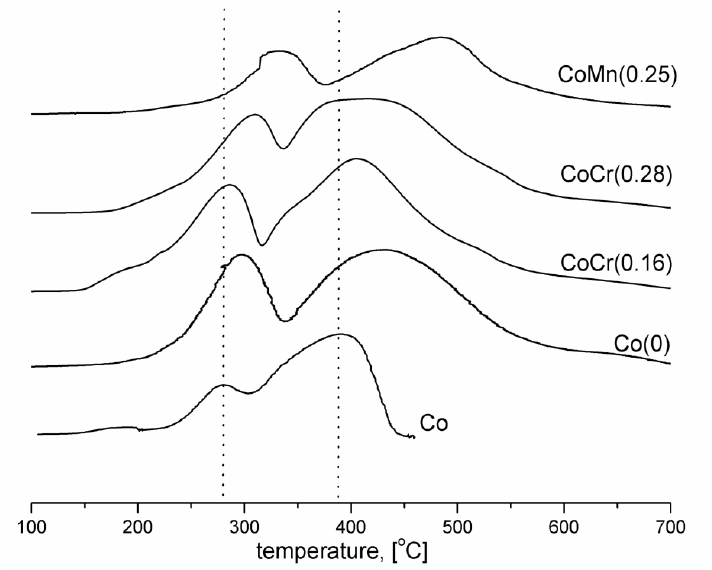
Figure 2. H -TPR profiles of the cobalt catalysts (flow 10% H 2 700